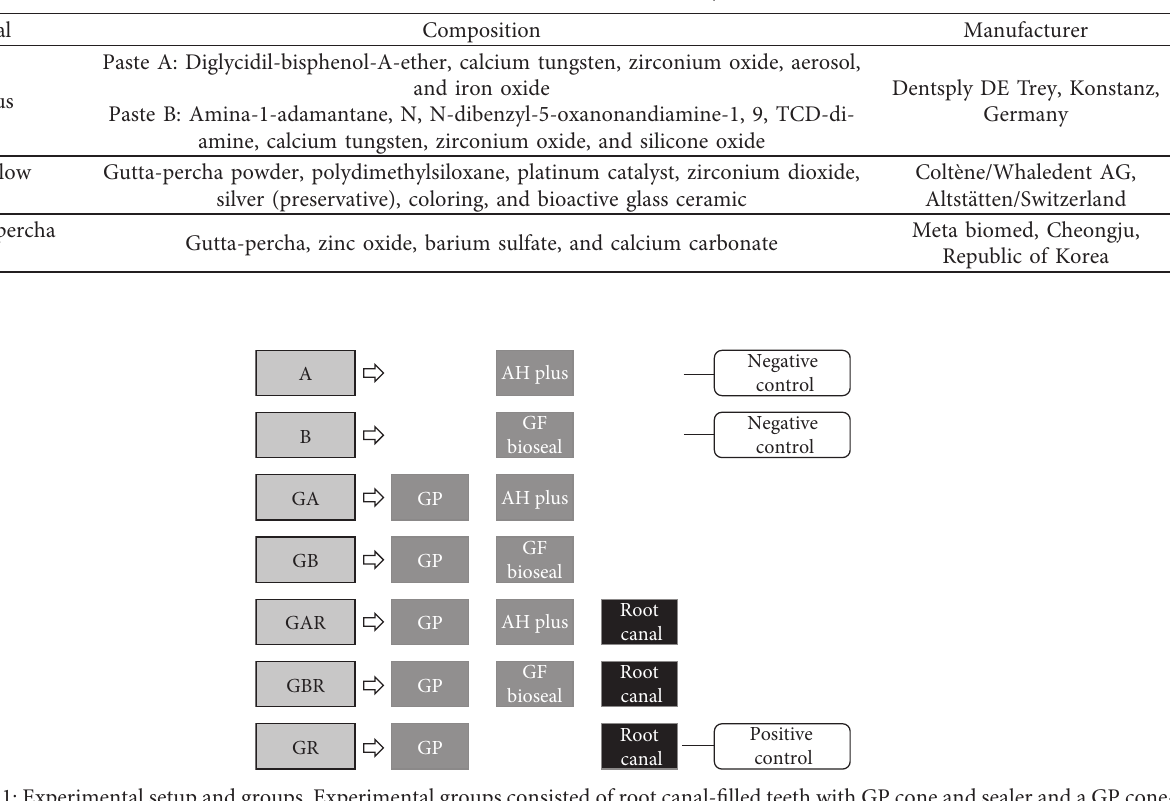
Table 1: Materials used in this study.